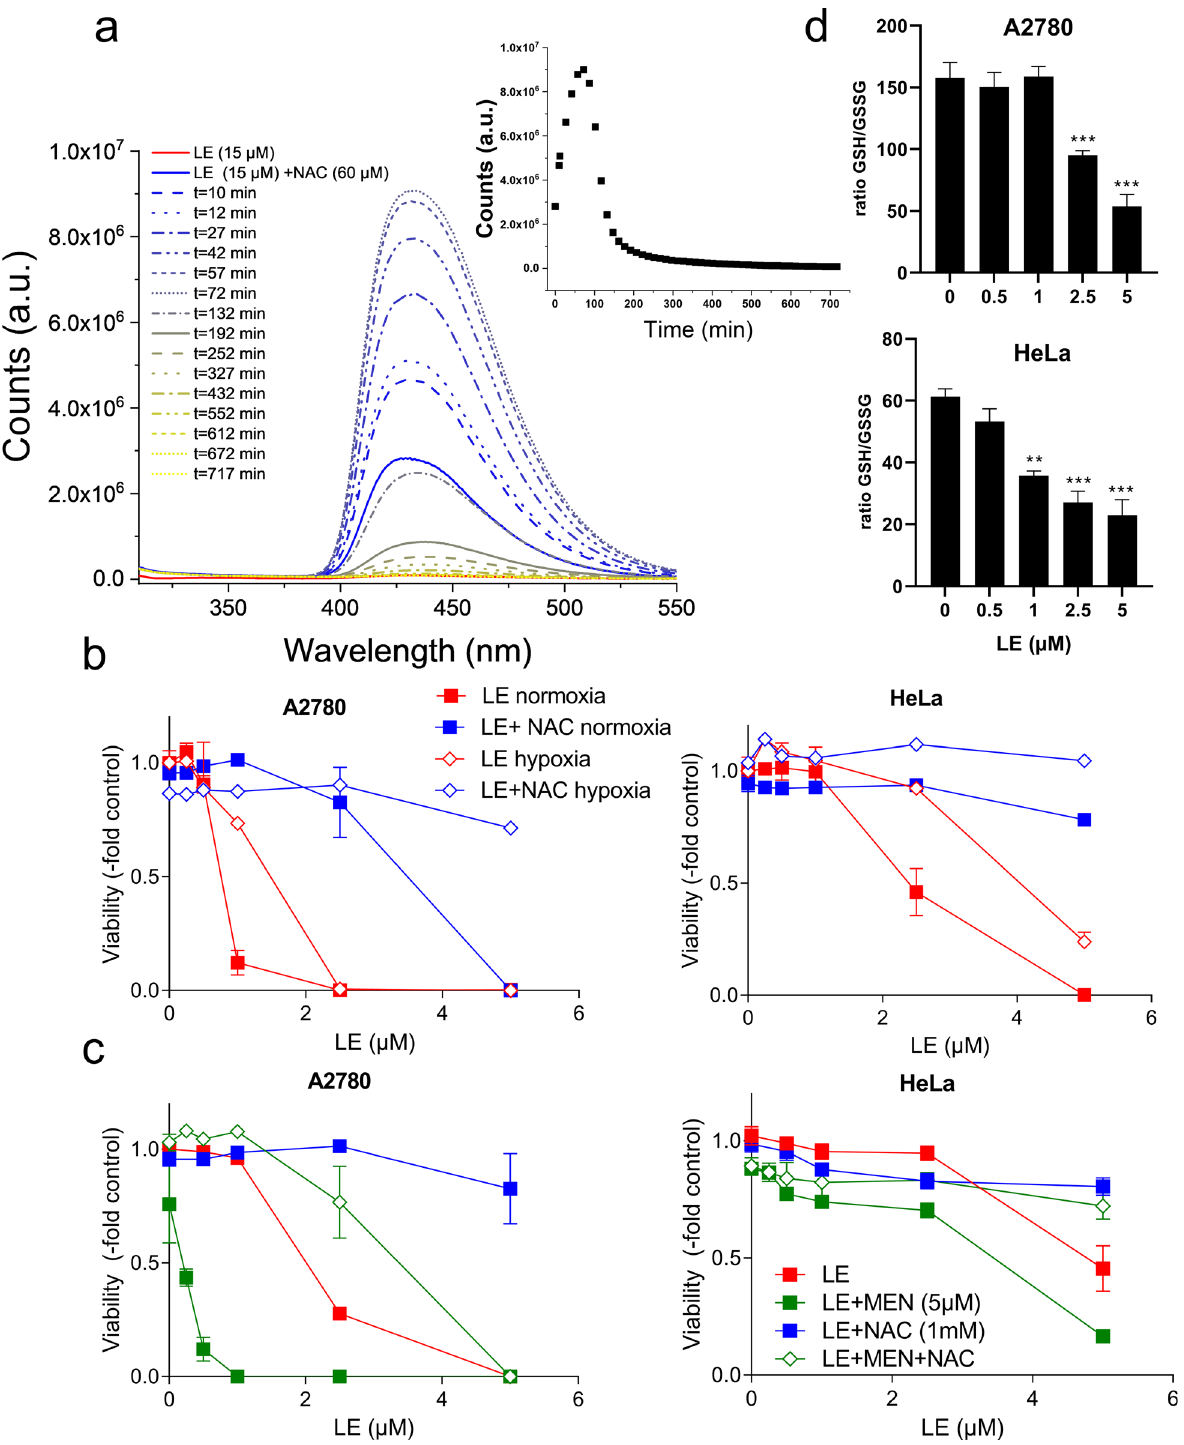
Fig. 7 The in fl uence of oxygen on the fl uorescence and Michael ’ s adduct formation of LE – NAC and its cytotoxic activity. a Fluorescence pro fi le over time of 15 μ M LE (red solid line) in combination with 60 μ M NAC in the absence of oxygen (solid and dashed lines). In the inset, fl uorescence intensity of the LE + NAC emission at 428 nm vs. time. λ exc = 280 nm; slits width: 2.5 nm/5 nm; Tris-HCl 50 mM, pH = 7.4. b Cell viability of indicated cell lines was measured with MTT after 72 h of LE treatment (with or without 1 mM NAC preincubation) under hypoxic and normoxic growth conditions. c Cell viability of A2780 and Hela cells 48 h after LE treatment with or without preincubation with MEN, NAC, or a combination of both. Each data point in ( b ) and ( c ) represents the mean ± SD of triplicate values from one representative experiment out of three delivering comparable results. All effect comparisons to the respective controls indicated signi fi cant differences by one-way ANOVA, p < 0.001, except in ( c ), right panel, where LE versus LE + NAC was p < 0.05, while LE + NAC versus LE + MEN + NAC did not signi fi cantly differ. d Determination of the ratio GSH/GSSG after 24 h of treatment with the indicated concentrations of LE was performed as described under “ Methods ” . Mean± SD of two independent experiments performed in triplicate are shown and signi fi cance as compared with untreated controls was tested by one-way ANOVA; ** p < 0.01; *** p <